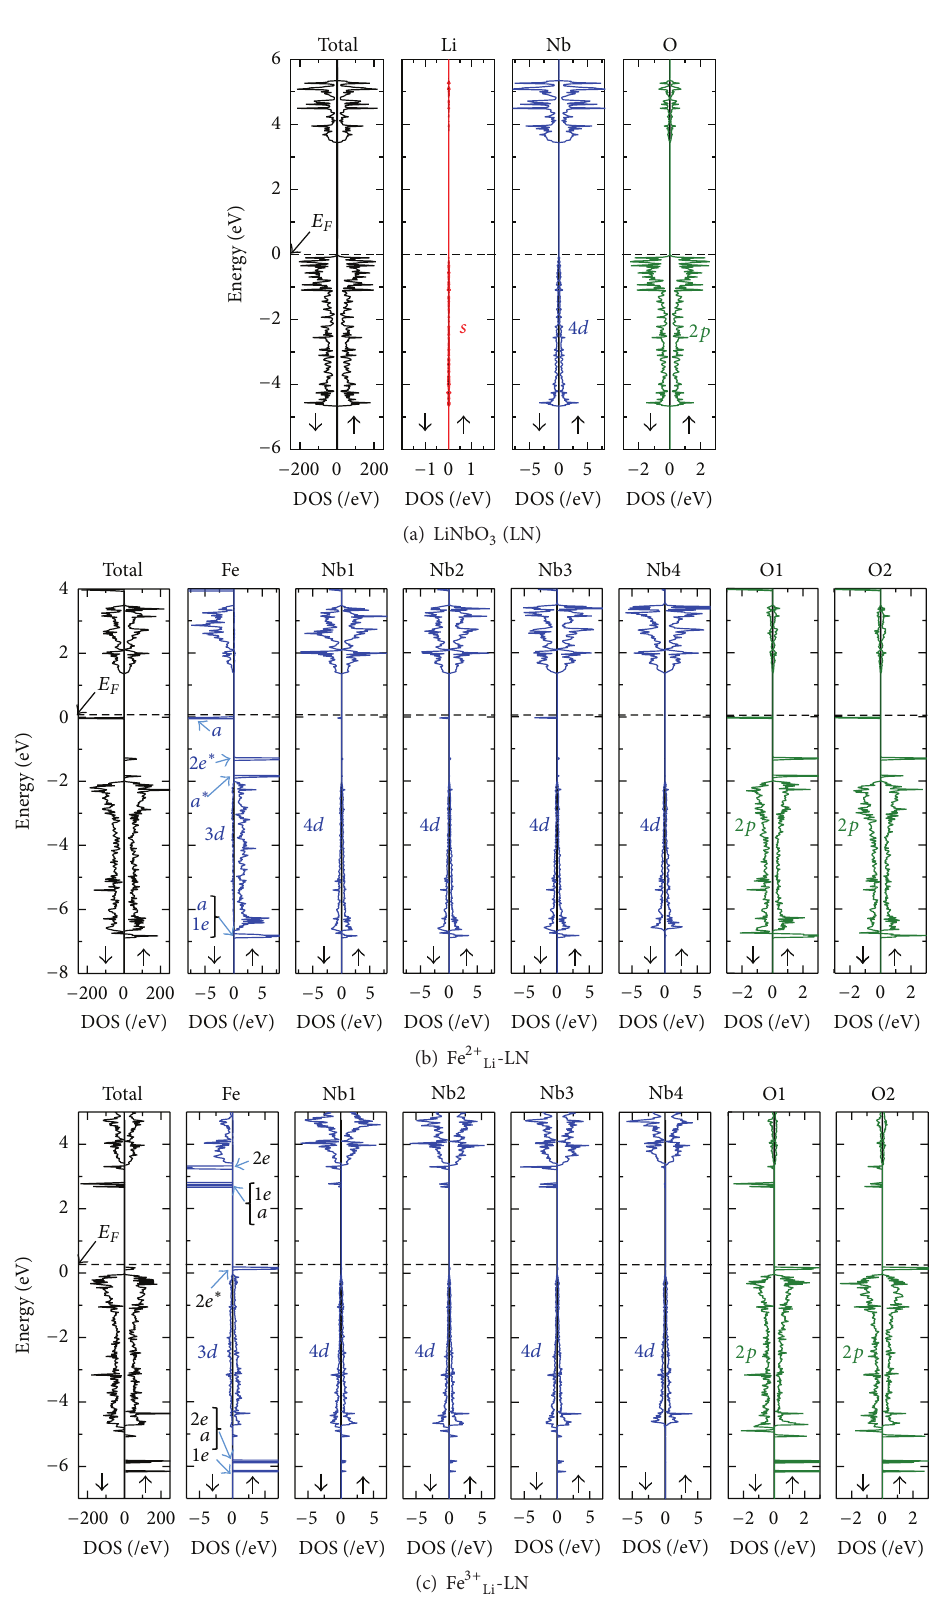
Figure 2: Total and partial density of states (DOS) of the (a) LN, (b) Fe 2+ Li -LN, and (c) Fe 3+ Li -LN